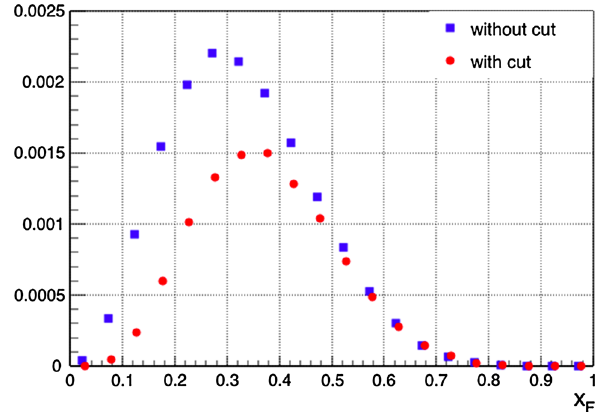
Fig. 2 The squared points represent the IC motivated x F distribution of (cid:4) ++ cc baryons. The circular point show this distribution re-weighted with the experimental reconstruction efficiency as a function of x F . The reconstruction efficiency is extracted from Fig.